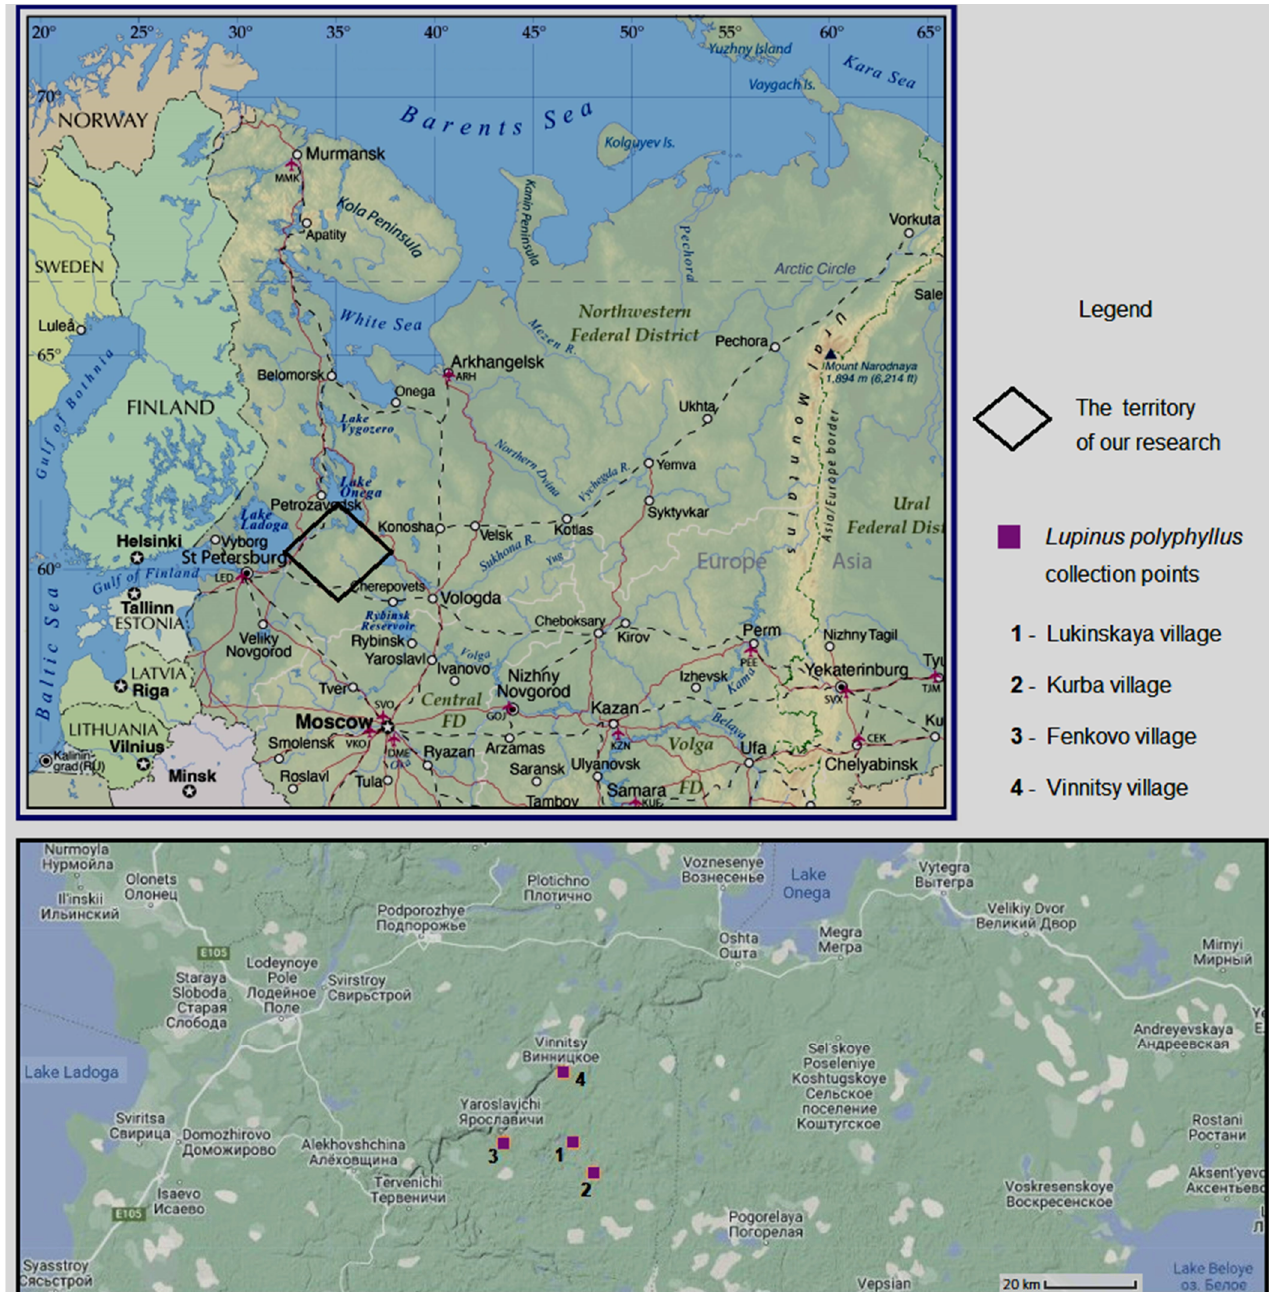
Figure 1. Sample locations in the Veps Forest Nature Park.